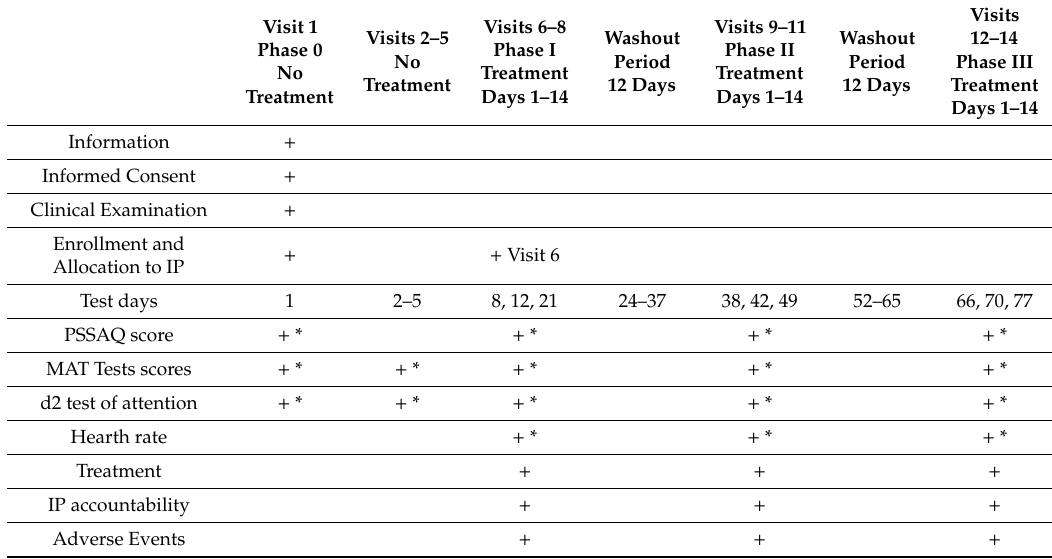
Table 3. Overall study design—healthy patient 14-day treatment, 4-week